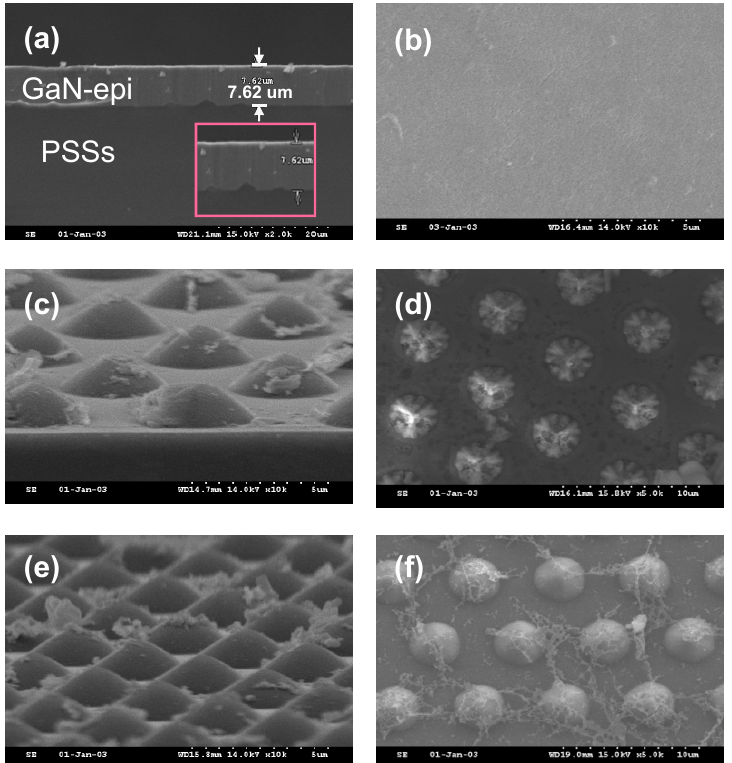
Figure 1. Cross-sectional and plane-view SEM images of the GaN-based epilayers on patterned sapphire substrates (GaN-epi/PSSs) morphologies under H 2 gas flowing at ( a , b ) 0 cm 3 /min, ( c , d ) 10 cm 3 /min, and ( e , f ) 25 cm 3 /min at 1200 °C for 3 h. The enlargement enclosed by the pink frame in panel ( a ) depicts a clear GaN-epi/PSS structure.